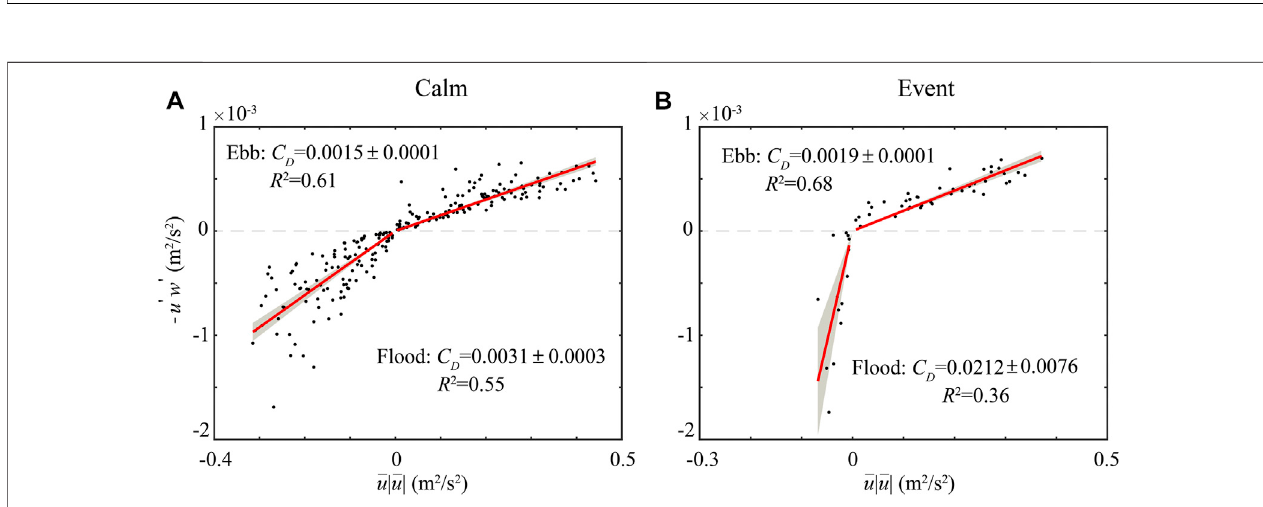
FIGURE10| CorrelationbetweenmeasuredturbulentReynoldsstress, − u ′ w ′ ,andthesign-preservingsquaredADV ’ sburstmeanvelocity, (cid:1) u | (cid:1) u | atS2duringwinter observation. (A) Calm period with time before January 18, (B) event period after 12:00 on January 24.